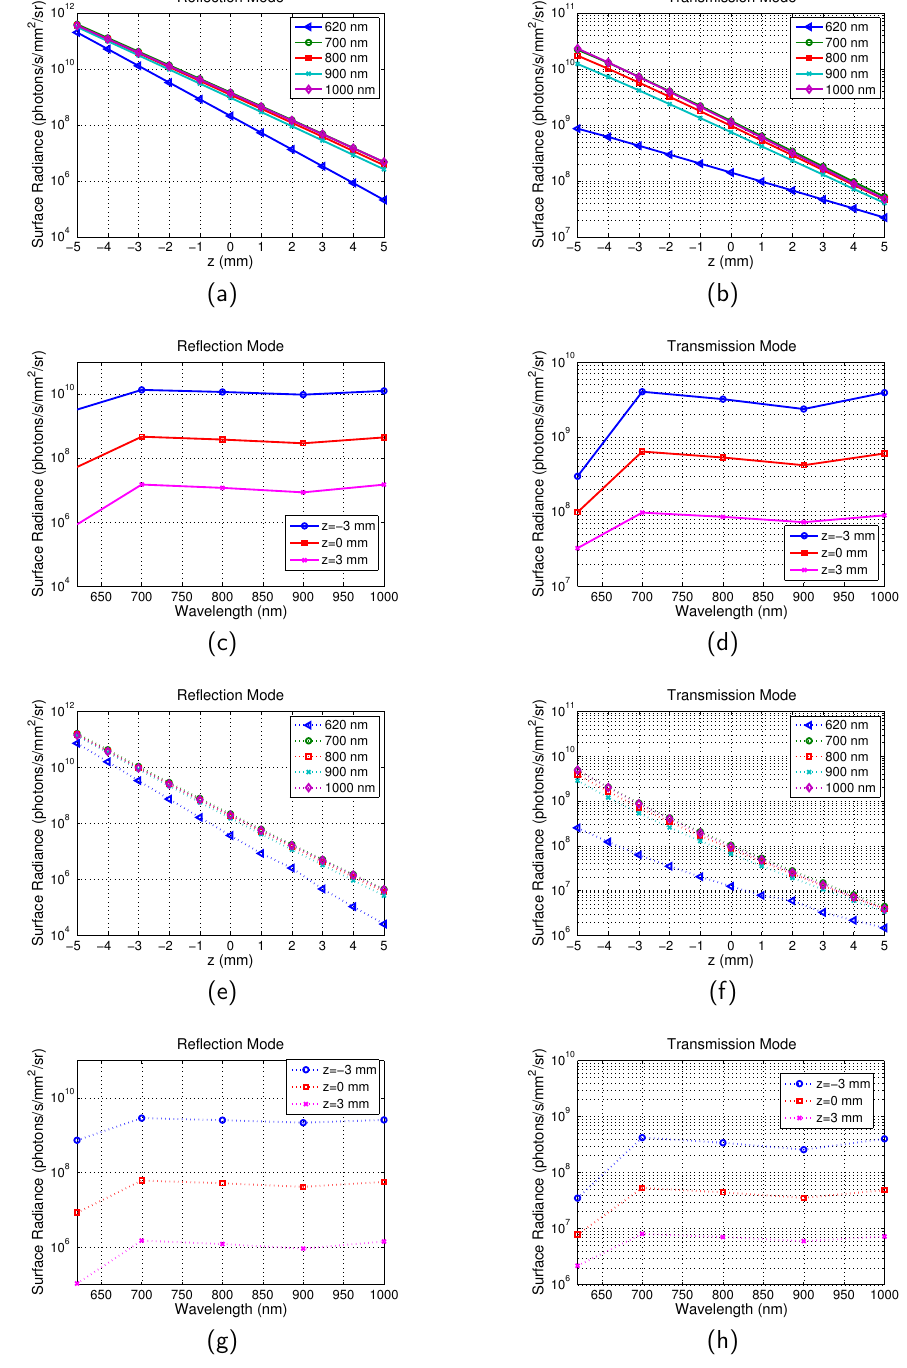
Figure 5. Calculation of Surface radiance. Optical properties are the same as those indicated by Figure 2. Separation between the two targets is D = 16mm. λ ex = 600nm. ( a ) Surface radiance vs. z for reflection mode of full-field system. ( b ) Surface radiance vs. z for transmission mode of full-field system. ( c ) Surface radiance vs. λ em for reflection mode of full-field system. ( d ) Surface radiance vs. λ em for transmission mode of full-field system. ( e ) Surface radiance vs. z for reflection mode of scanning system; ( f ) Surface radiance vs. z for transmission mode of scanning system. ( g ) Surface radiance vs. λ em for reflection mode of scanning system. ( h ) Surface radiance vs. λ em for transmission mode of scanning